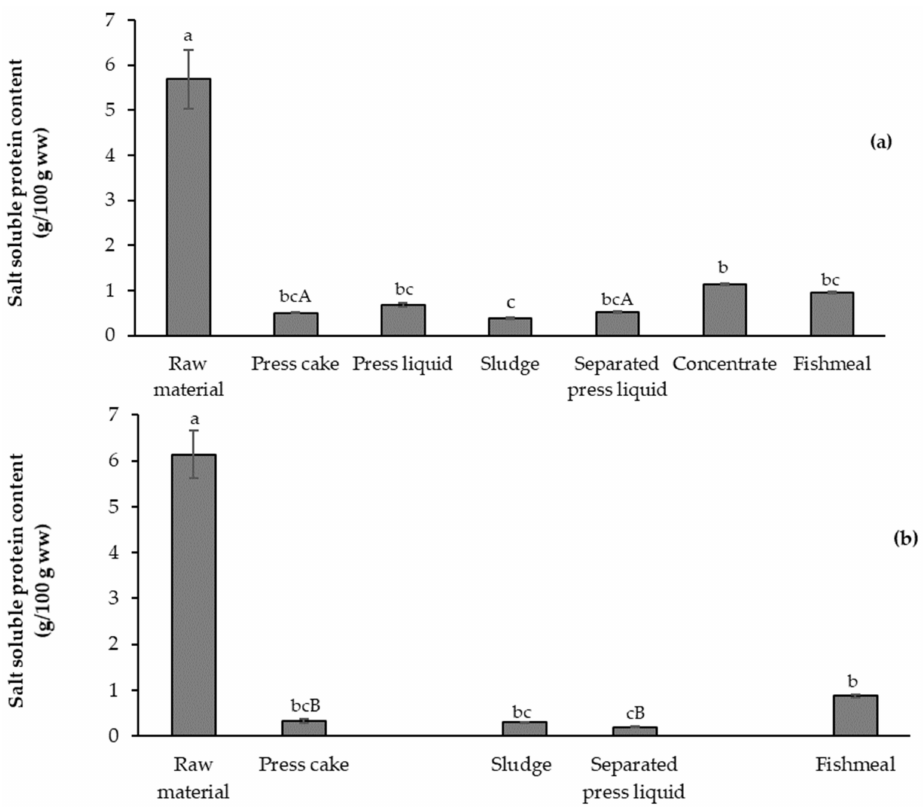
Figure 3. Salt soluble proteins (%, g SSP/100 g ww) in chosen BW ( a ) and MHB processing samples during industrial fishmeal production ( b ). Lowercase letters indicate significant differences in SSP between sampling locations, while uppercase letters indicate significant differences between two types of raw materials at the same processing step. Statistical significance levels were set to p < 0.05 for all